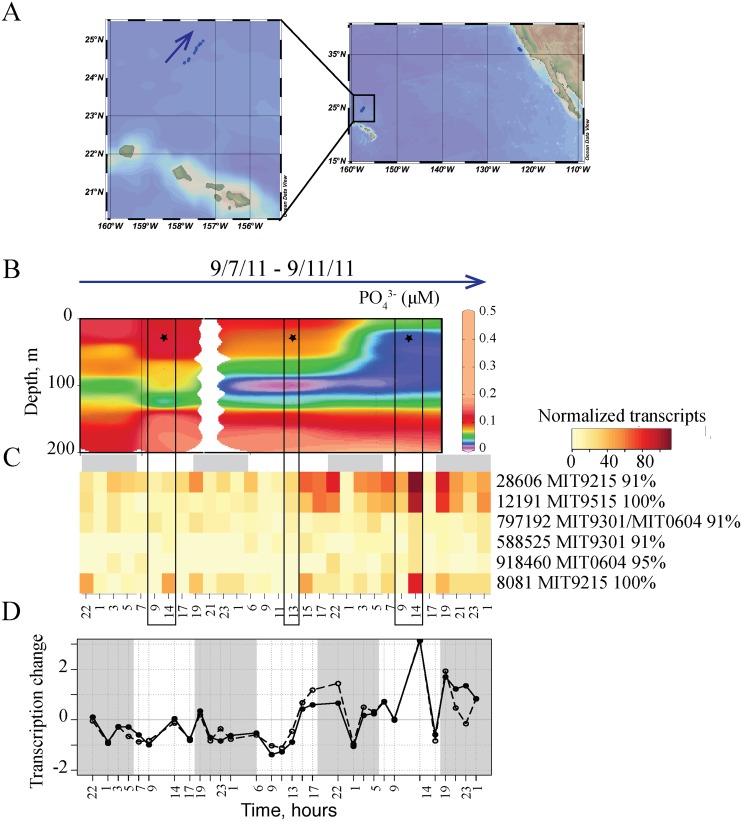
Transcription of the Phosphate Transporter Gene pstS by Specific Prochlorococcus OTUs Associated with Inorganic Phosphate Concentrations in the NPSG Study.(A) Location and transect of the NPSG diel study [12,45]. CTD cast stations following the drifting sampler are shown. (B) Phosphate concentrations measured from seawater collected from a CTD Niskin bottle following the drifting sampler are shown for the NPSG transect [45]. Eight depths were sampled at each of the five sampling locations, and the stars indicate 25 m depth. The boxes indicate the midday time of depth profile sampling for phosphate. (C) Normalized pstS transcript abundances among Prochlorococcus OTUs during the 72h NPSG study. (D) Temporal patterns of total Prochlorococcus pstS transcript abundances detected by MAGC (open circle) here and by WGPB (closed circle) [12].